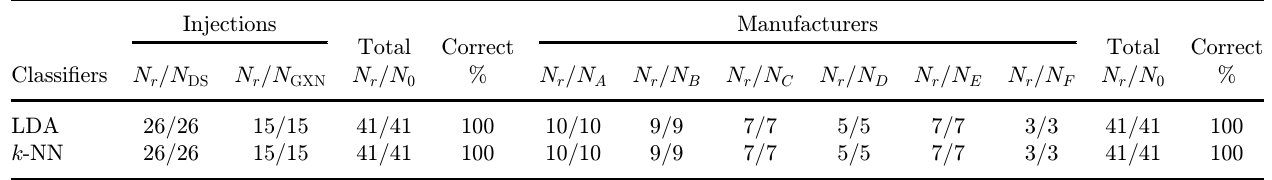
Table 3. Summary of the identi¯cation results using di®erent